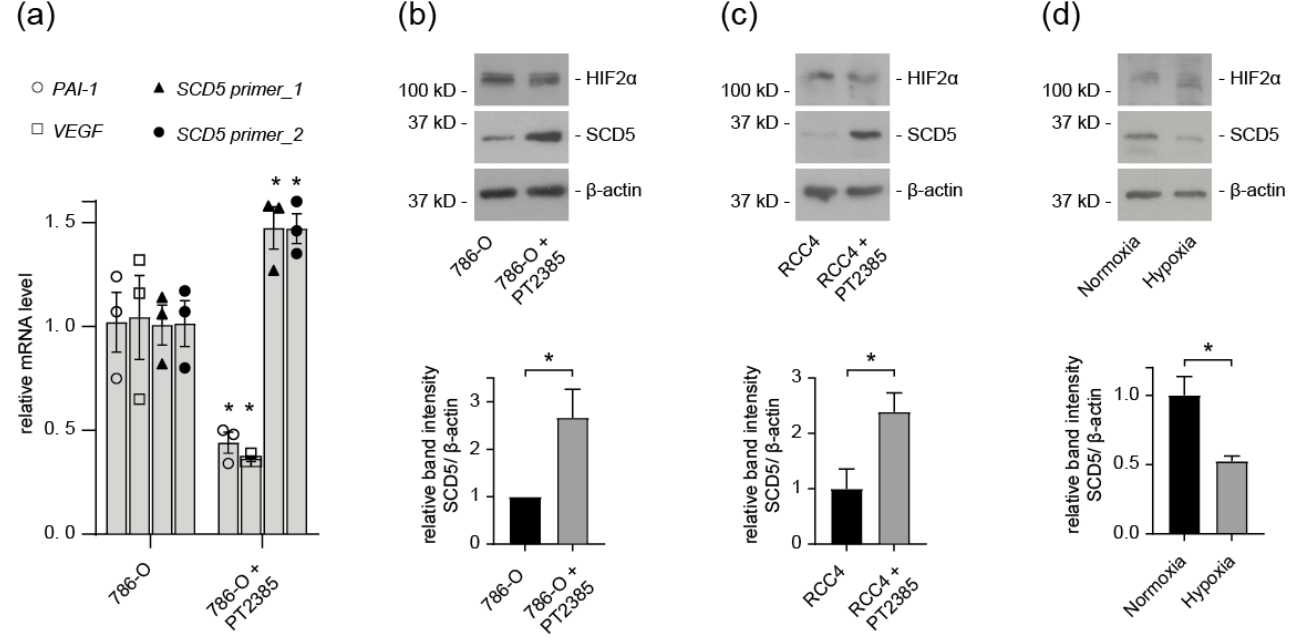
Figure 4. SCD5 expression depends on HIF2 α . ( a ) 786-O cells were incubated with the HIF2 α inhibitor PT2385 (1 µ molar) for 72 h. RNA expression of SCD5 , VEGF , and PAI-1 were assessed by RT-qPCR relative to HSPCB. n = three for each experiment. Data are represented as mean ± SEM. * p < 0.05 compared to untreated cells ( t -test). ( b ) SCD5 protein levels are restored after treatment with the HIF2 α inhibitor PT2385. The 786-O cells were incubated with the HIF2 α inhibitor PT2385 (1 µmolar) or DMSO (control) for 72 h, and cell lysates were assessed by immunoblotting with anti- SCD5 and anti-HIF2 α antibody. Quantification of three independent experiments. Data represent mean ± SEM. * p < 0.05 ( t -test). kD, kilodalton. Full-length blots are presented in Supplementary Figure S2. ( c ) Immunoblot of RCC4 cells that were treated with PT2385 (1 µM) or DMSO control. Quantification of relative SCD5 levels from three independent experiments. Data are presented as mean ± SEM. * p < 0.05 ( t -test). Full-length blots are presented in Supplementary Figure S2. ( d ) SCD5 protein levels after hypoxia treatment of RPTEC cells. Quantification from three independent experiments. Data represent mean ± SEM. * p < 0.05 ( t -test). kD, kilodalton. Full-length blots are presented in Supplementary Figure S2.